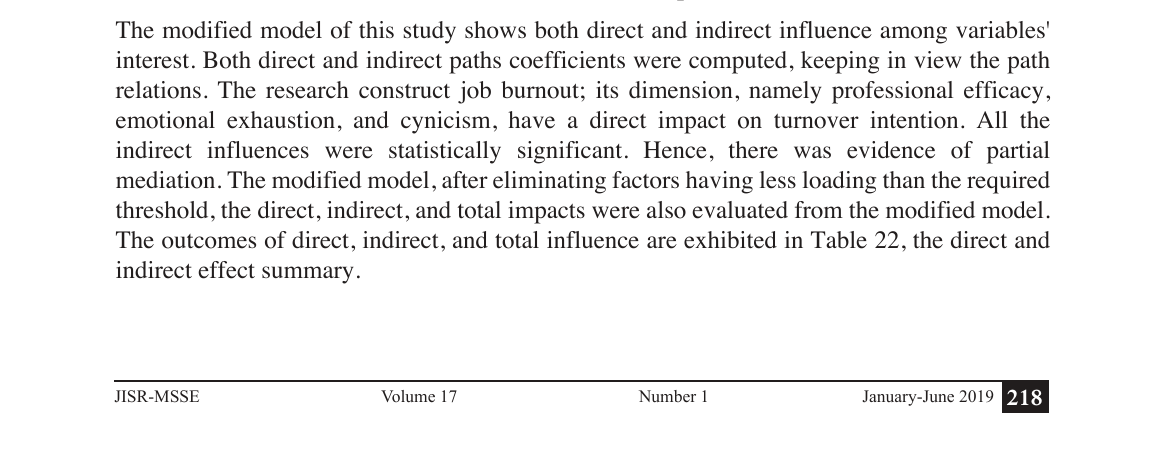
Direct, Indirect, and Total Effect on Modified Conceptual